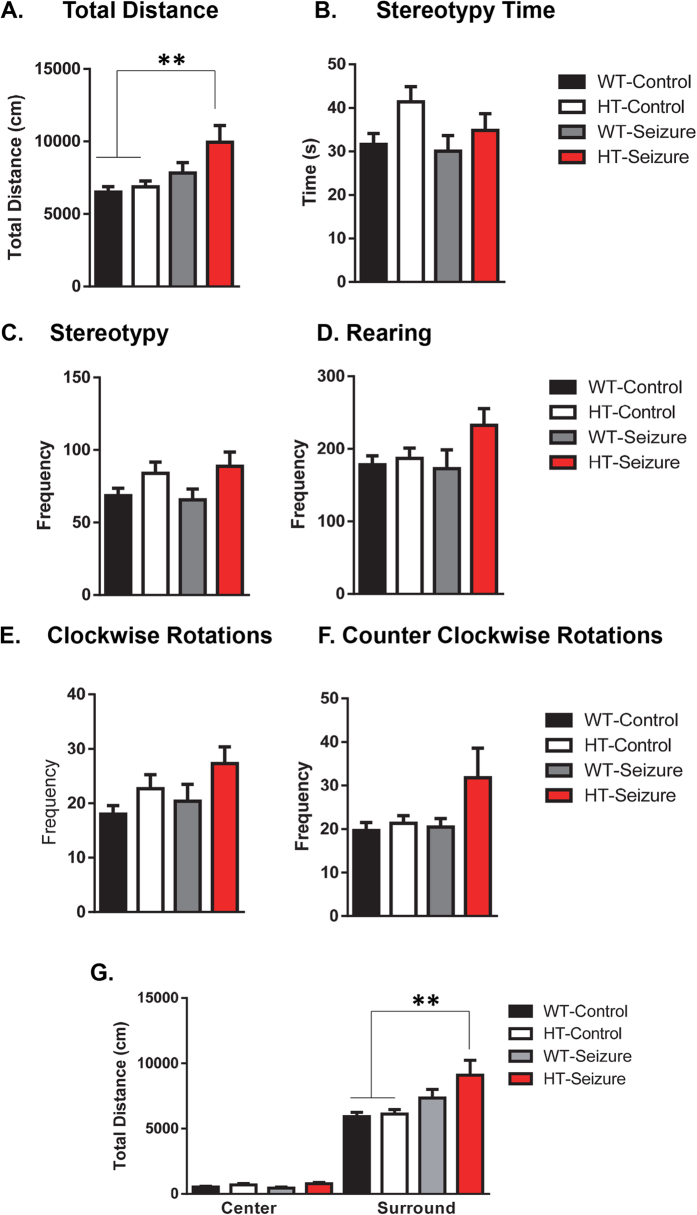
Status epilepticus in NS-Pten HT mice resulted in hyperactivity in the open field.The mice were placed in an open field test for thirty minutes and several measurements of locomotor behavior were taken. (A) Total distance, (B) time performing stereotypy behavior, (C) frequency of stereotypy events, (D) number of rearing events, (E) number of clockwise rotations, and (F) number of counterclockwise rotations. The data were then reanalyzed by center and surround regions of the open field apparatus. (G) Total distance in the center and surround region of the open field test. Data are shown as mean ± standard error of the mean. **P > 0.01. WT-control n = 17, HT-control n = 12, WT-Seizure n = 14, HT-Seizure n = 14.